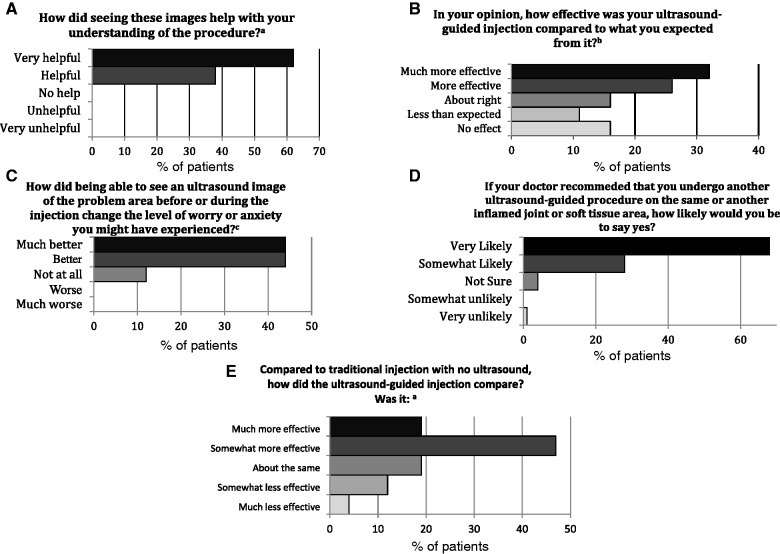
Patients’ views related to observing US images during proceduresan = 26, bn = 19, cn = 25.